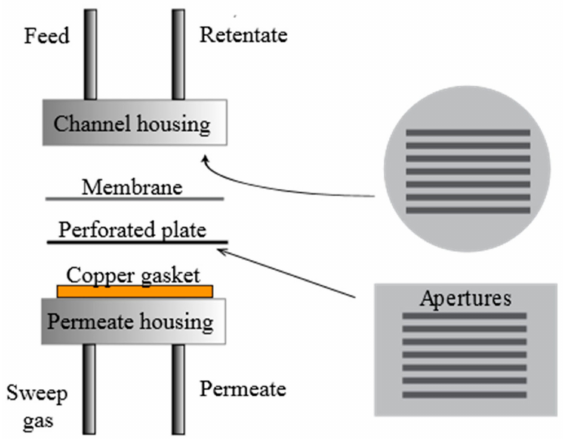
Figure 1. Sketch of the microchannel reactor